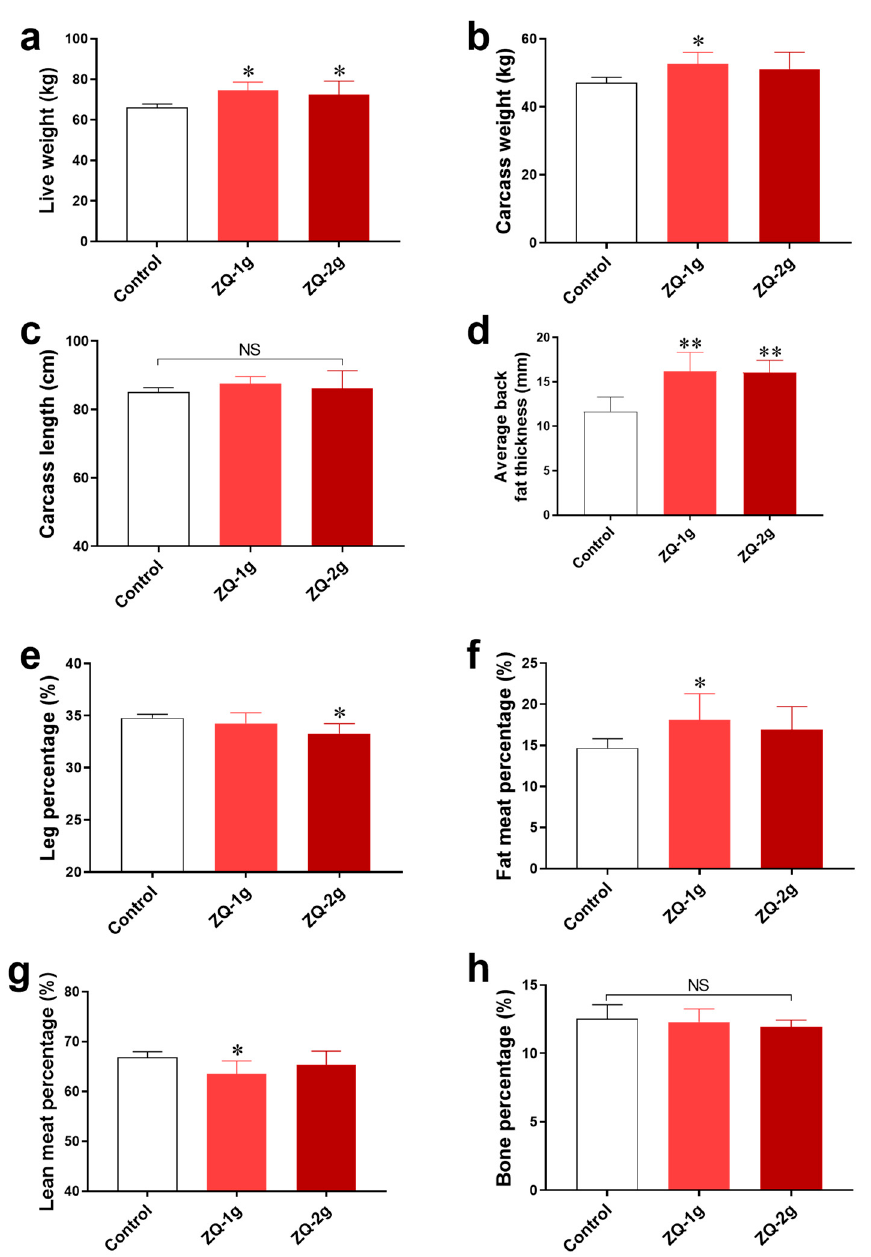
Figure 4. Effects of ZQ on carcass and meat quality traits in pigs. ( a ) Live weight. ( b ) Carcass weight. ( c ) Carcass length. ( d ) Average backfat thickness. ( e ) Leg percentage. ( f ) Fat meat percentage. ( g ) Lean meat percentage. ( h ) Bone percentage. Note: * indicates p < 0.05, ** indicates p < 0.01, and NS indicates no significant differences ( p > 0.05). Table 3. Effects of ZQ on the biochemical indices of blood.